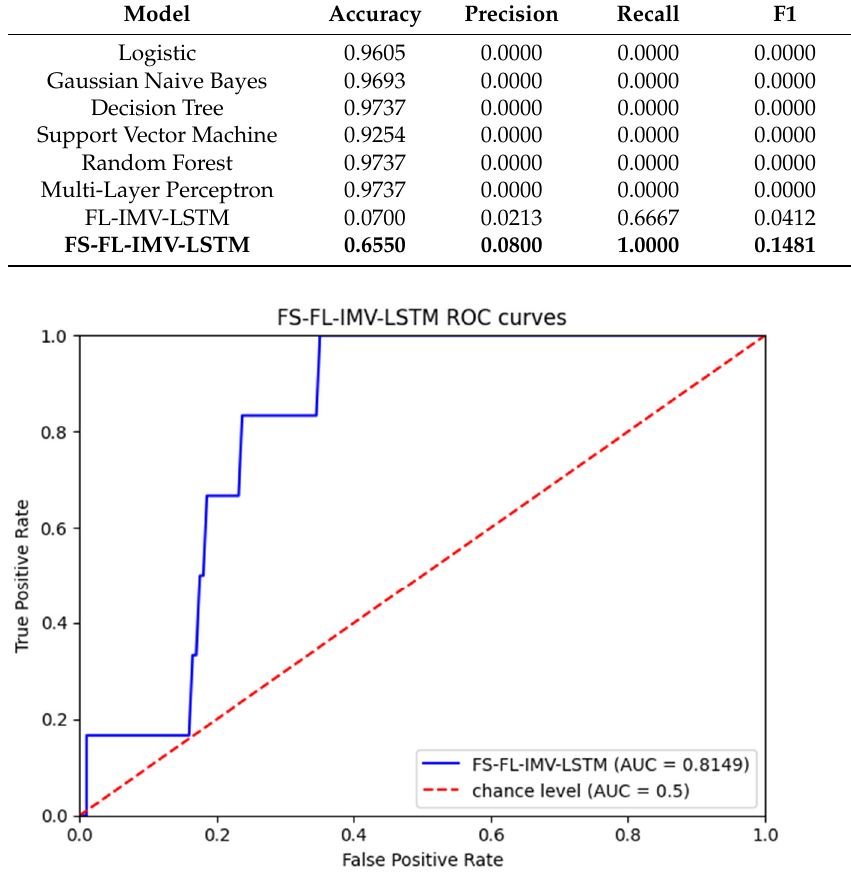
Figure 3. FS-FL-IMV-LSTM ROC curves. Table 8. Prediction Performance.